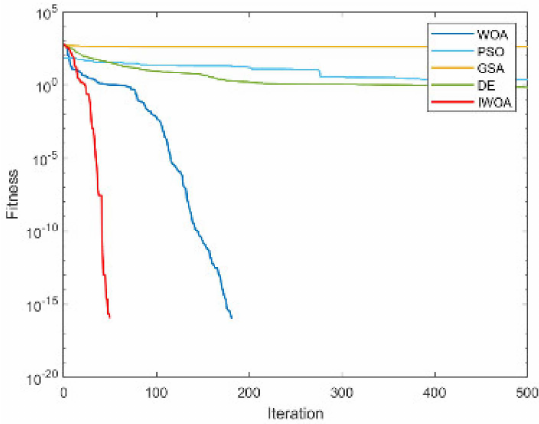
Figure A7. The convergence curve for solving F7.